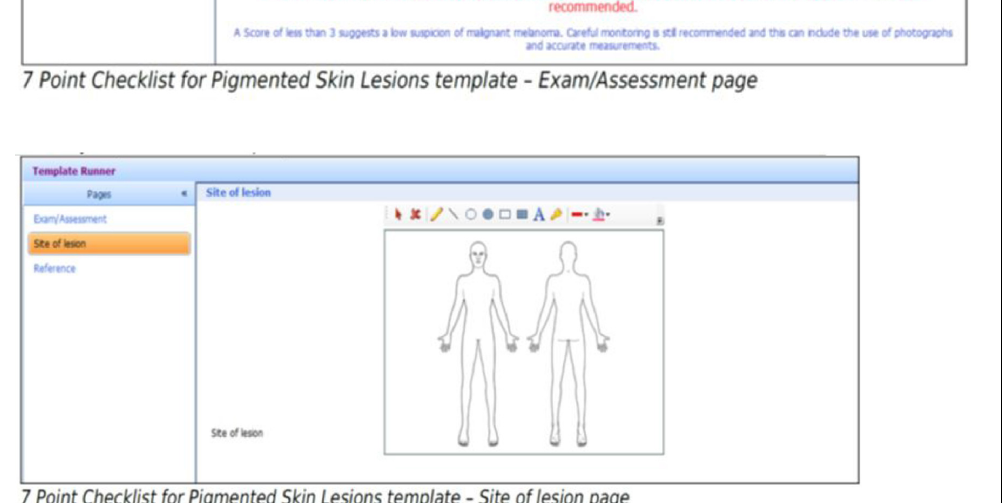
Pannebakker M M et al . BJGP Open 2019; DOI: